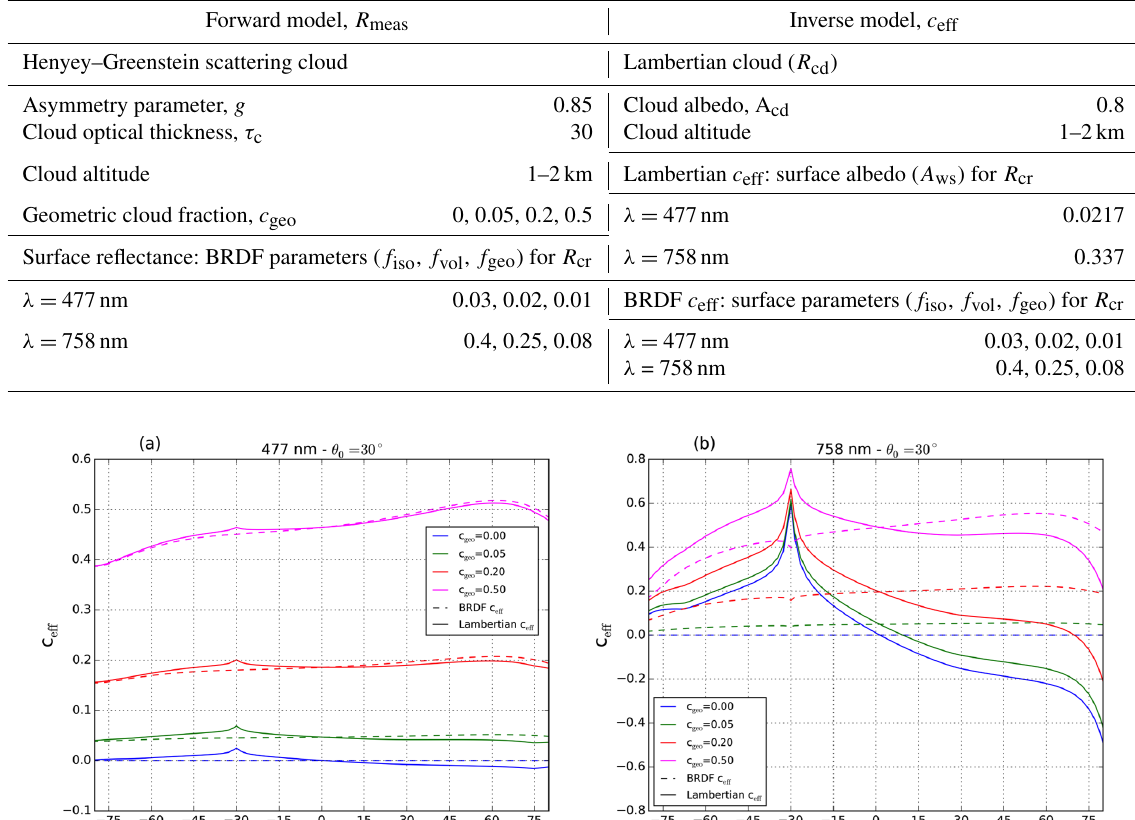
Table 1. Settings for Lambertian and BRDF c eff simulations in Sect. 4.1. Inverse model for Lambertian c eff reproduces current O 2 –O 2 and FRESCO+ retrievals, with Lambertian surface and Lambertian cloud. Inverse model for BRDF c eff reproduces the retrieval accounting for surface BRDF effects.